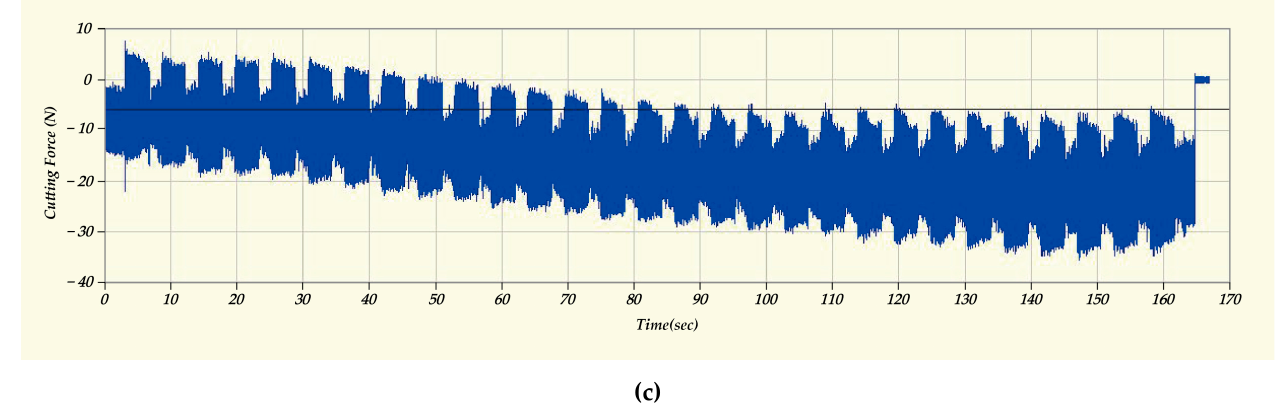
Figure 9. Cutting force diagram of ( a ) Fx, ( b ) Fy, and ( c ) Fz using the experimental factor A1B1C1D1E1(N1). The measured amount of deformation, surface roughness, and cutting force from the 16 sets of experiments are shown in Table 4.